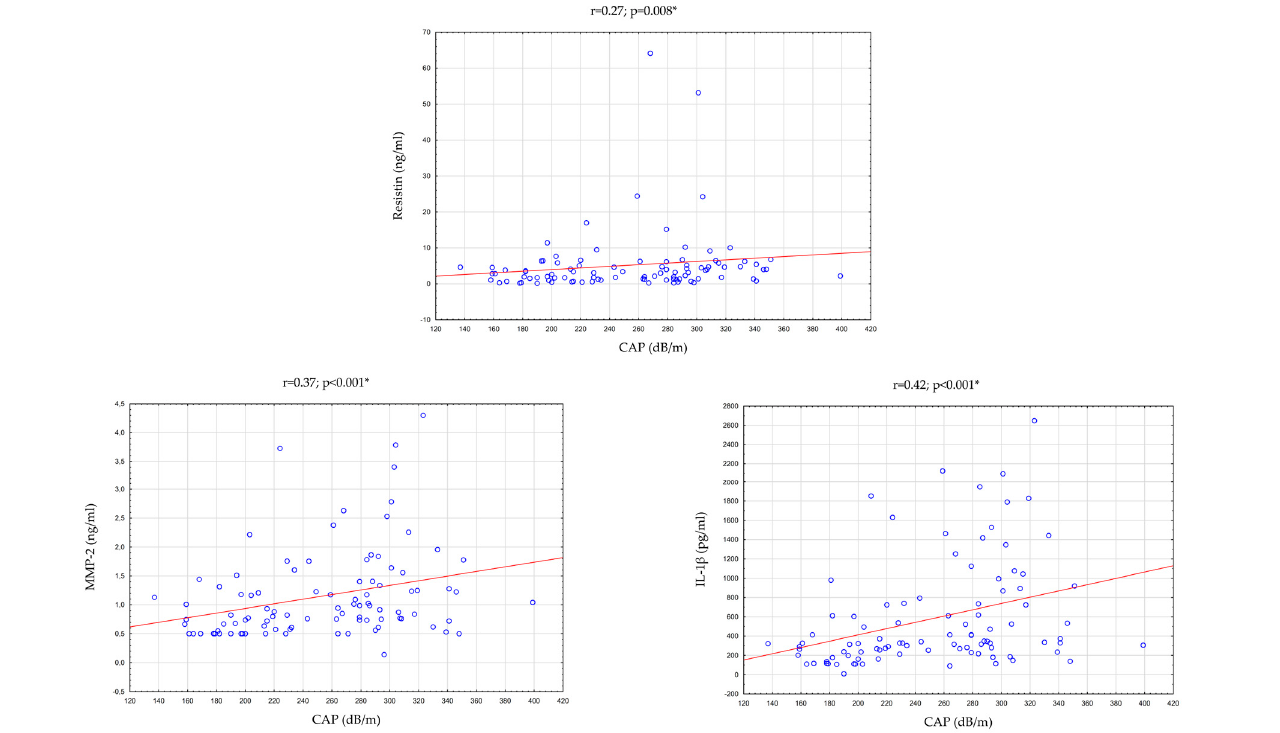
Figure 4. Statistically significant correlations between CAP and the concentration of adipokines and cytokines in saliva.